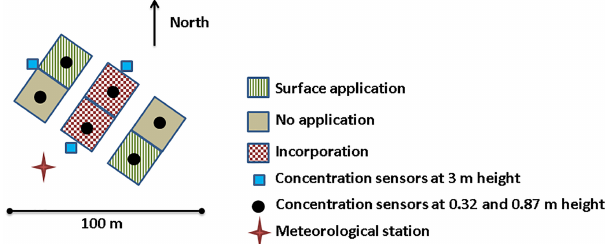
Identical to C1 except for the number of sensors Known Identical to C2 except for the number of sensors Unknown Identical to C2 except for the background concentration estimation Unknown Identical to C4 except for the background concentration estimation 2 No Unknown Identical to C3 except for the background concentration estimation ∗ Each treatment has three plots (repetitions).